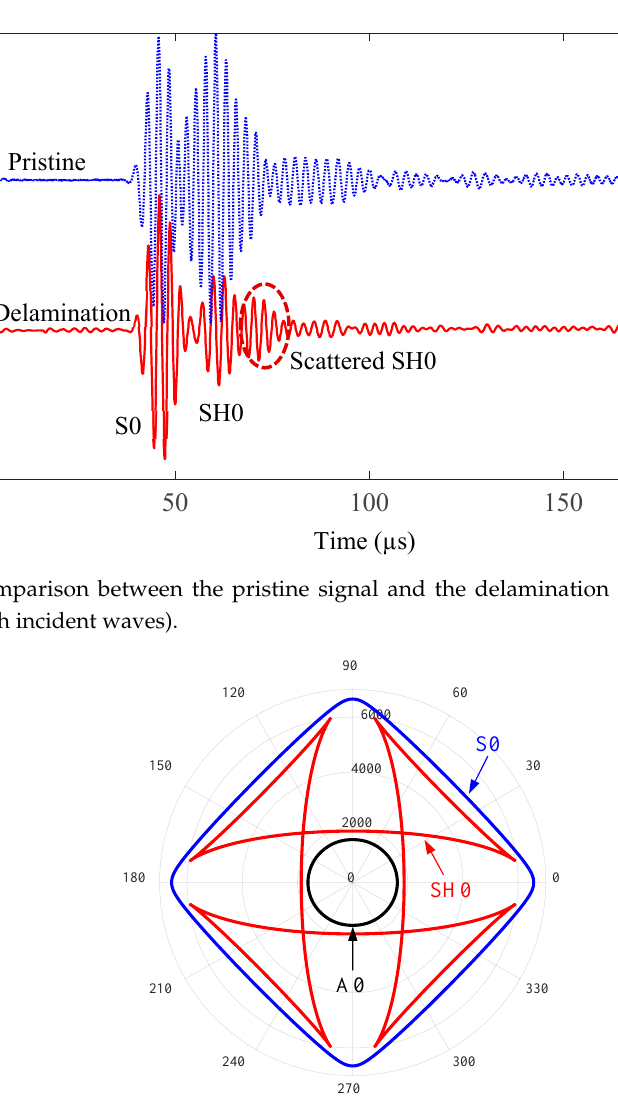
Figure 15. The new methodology for the localization of damage point: ( a ) pulse-echo signals of the